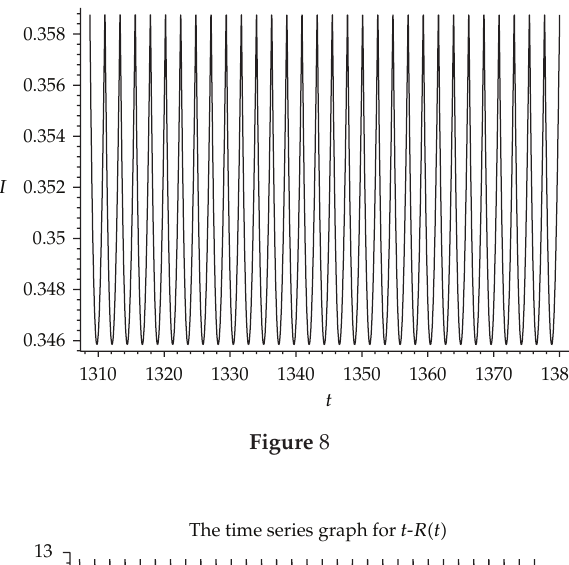
The time series graph for t - R ( t